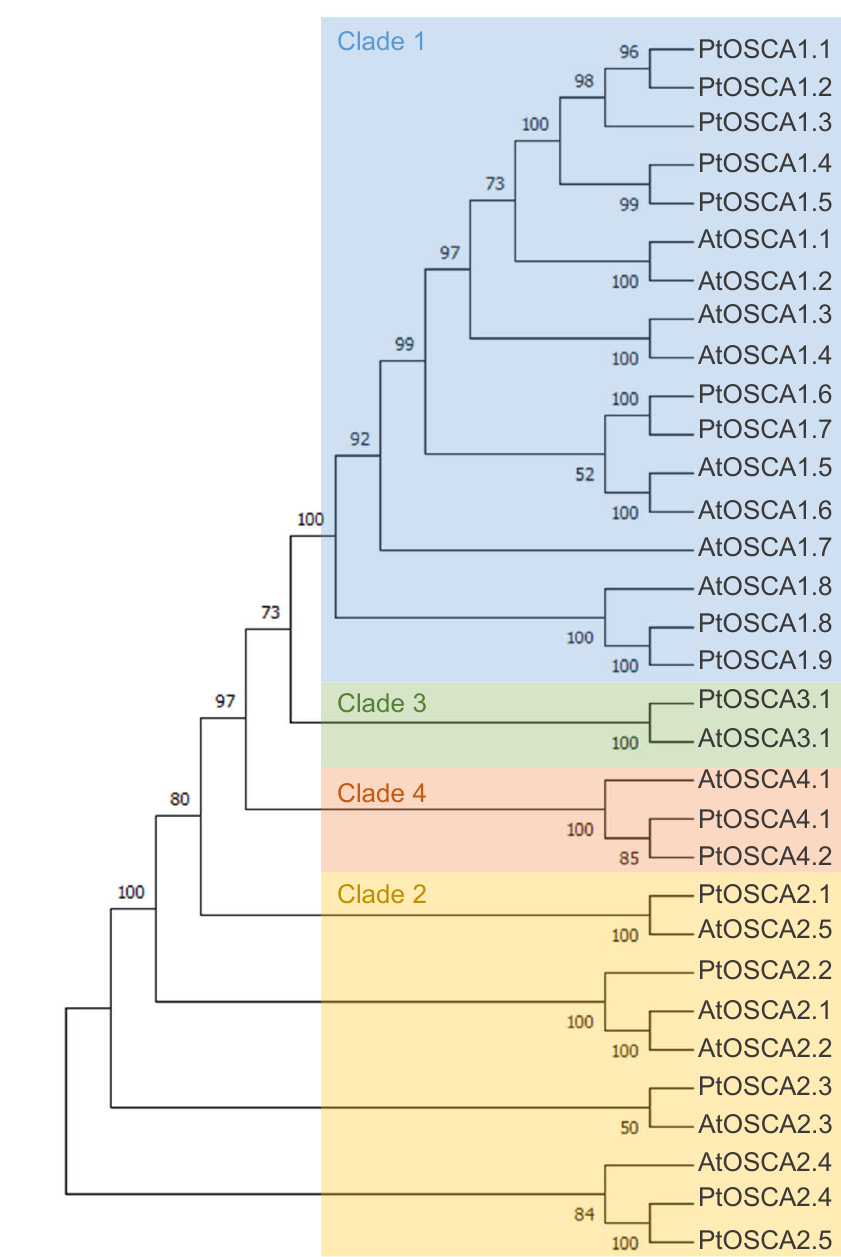
Figure 3. Maximum-likelihood phylogenetic tree of OSCA of Arabidopsis thaliana and Populus tri- chocarpa . The percentage of trees in which the associated taxa clustered together is shown next to the branches. Initial trees for the heuristic search were obtained automatically by applying Neighbor-Join and BioNJ algorithms to a matrix of pairwise distances estimated using the JTT model, and then selecting the topology with a superior log-likelihood value. The tree is drawn to scale, with branch lengths measured in number of substitutions per site. This analysis involved 22 amino acid sequences. All positions with less than 50% site coverage were eliminated, i.e., fewer than 50% alignment gaps, missing data, and ambiguous bases were allowed at any position (partial deletion option). There were a total of 770 positions in the final dataset. Evolutionary analyses were conducted in MEGA X. The four clades are colored: blue (Clade 1), yellow (Clade 2), green (Clade 3), and orange (Clade